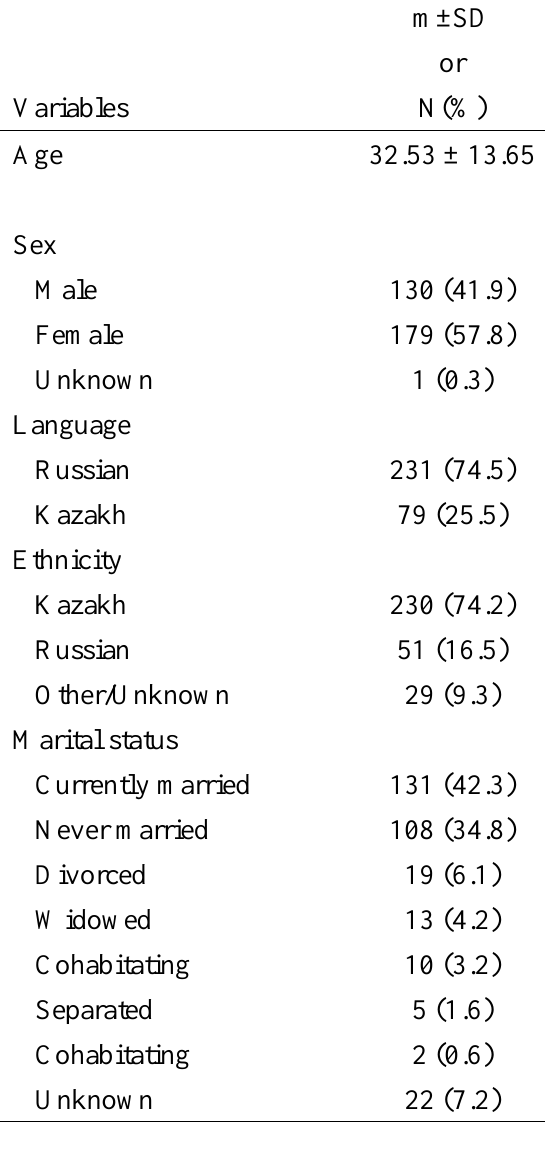
Table 2: Demographic descriptive characteristics of